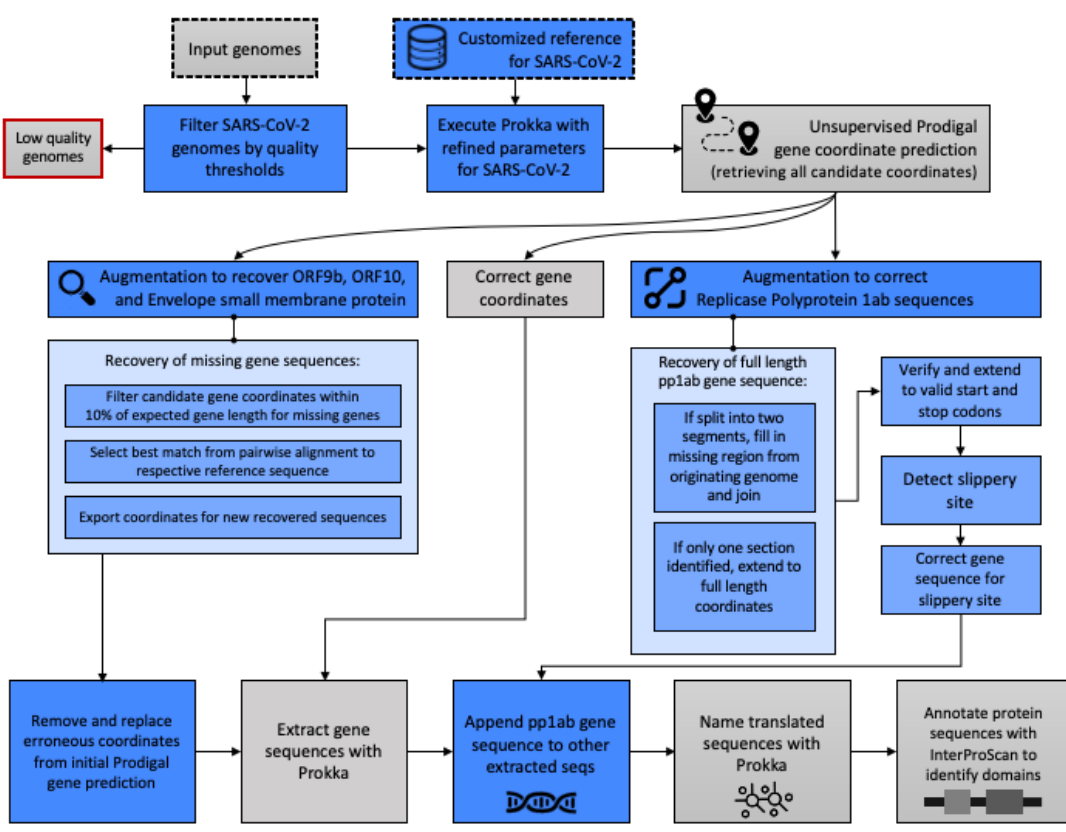
Figure 1. Pipeline schematic for semi-supervised identification of molecular targets. The data and analytic steps comprising our SARS-CoV-2 annotation pipeline described in Methods Sections 2.1–2.3 are indicated. Input data are indicated with a dashed line and discarded data, e.g., genomes below quality thresholds, are indicated with a red line. Blue boxes indicate steps where our augmentation of base Prokka and Prodigal yield methodological advancements specific to the requirements of SARS-CoV-2